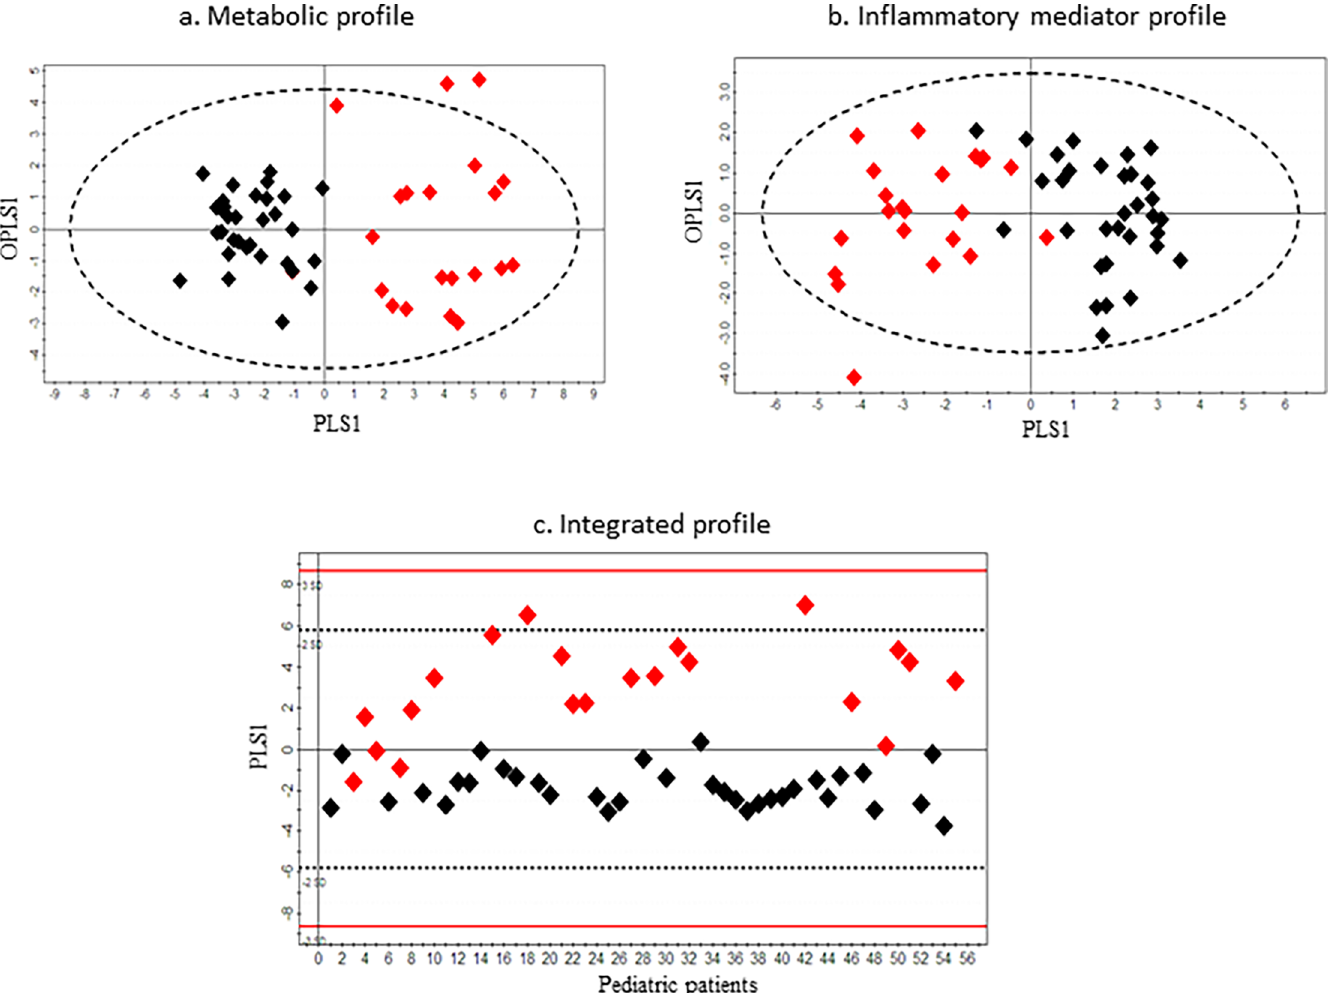
Fig 2. OPLS-DA score scatter plots distinguishing pediatric appendicitis patients from pediatric control patients using (a) metabolic profile (R 2 Y = 0.74, Q 2 = 0.54), (b) inflammatory mediator profile (R 2 Y = 0.75, Q 2 = 0.63), and (c) integrated metabolic and inflammatory mediator profile (R 2 Y = 0.69, Q 2 = 0.67). Red diamonds represent the pediatric appendicitis patients and black diamonds represent the pediatric control patients.